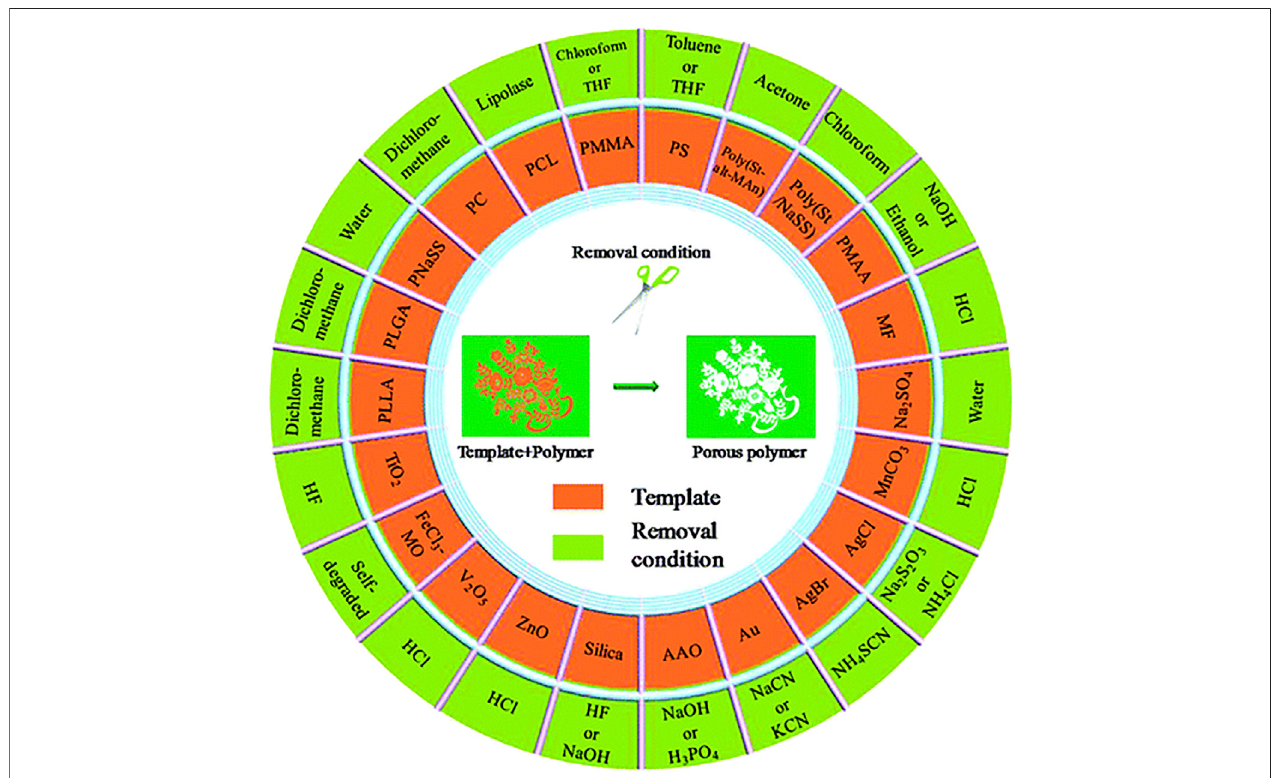
FIGURE 1 | Commonly used polymer templates and their removal conditions (Wu et al.,